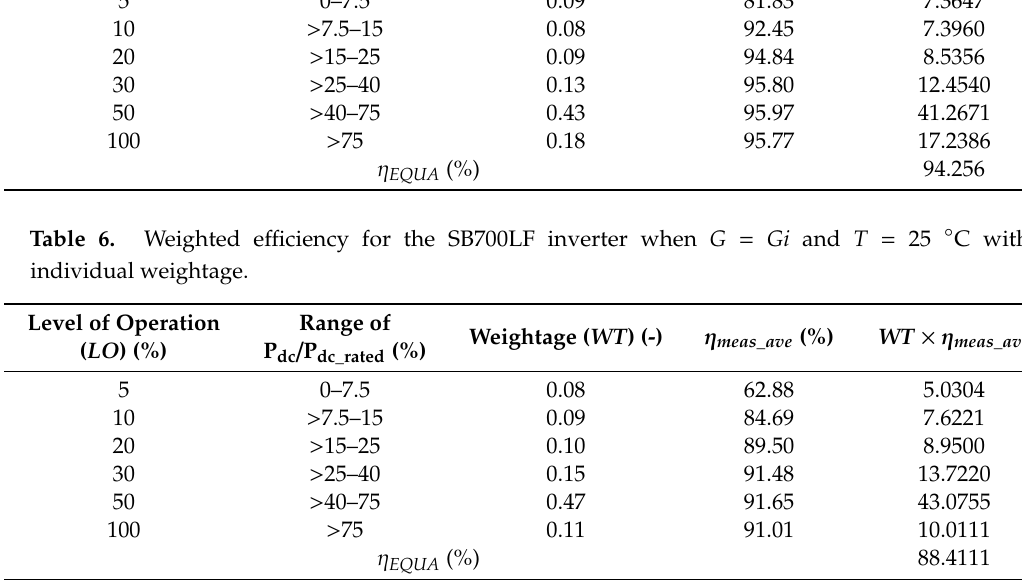
Table 6. Weighted efficiency for the SB700LF inverter when G = Gi and T = 25 °C with individual weightage.